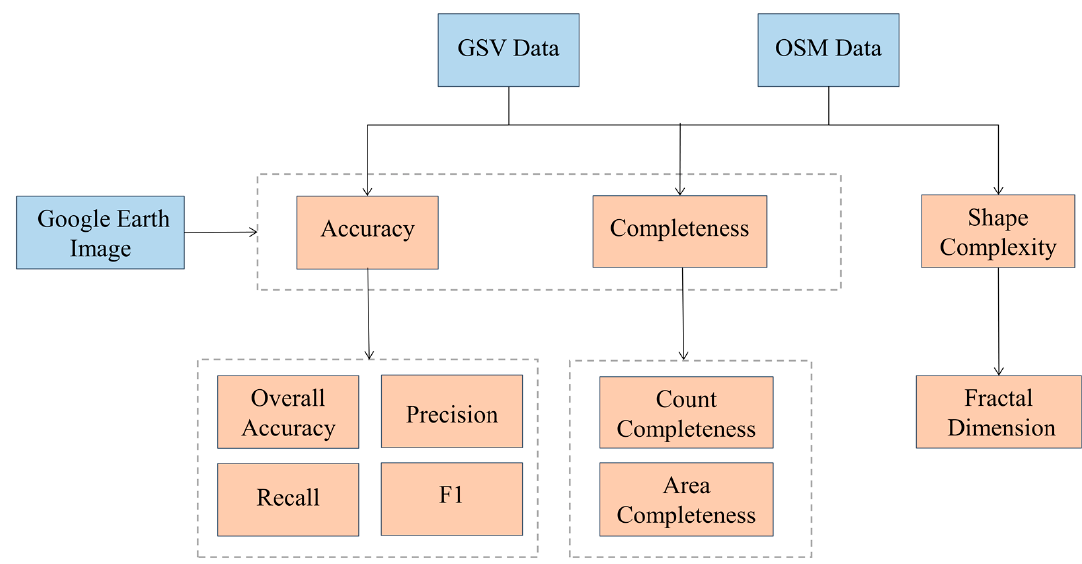
Figure 2. The workflow of evaluation method.